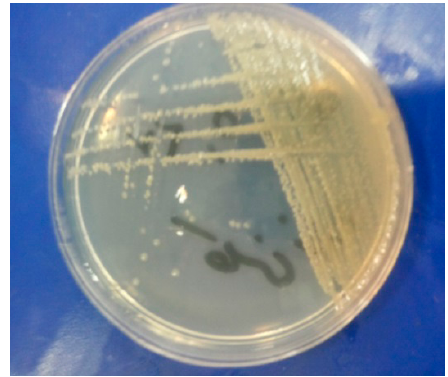
Figure 1. Escherichia coli .